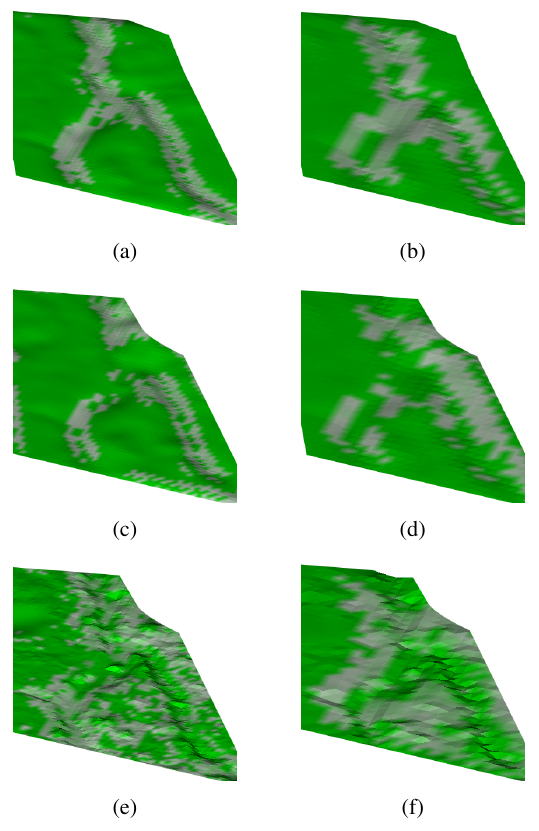
Figure 9. Detected key planes on the DEMs with different resoultions, key planes are drawn in gray. First row: DEMs for the ALS data a: cell size of 0.8 m b: cell size of 1.6 m; middle row: DEMs for the photogrammetric point cloud with a resolution of 40 cm with cell size of 0.8 m (c) and 1.6 m (d); last row: photogrammetric point cloud with a resoultion of 6 cm with cell size of 0.8 m (e) and 1.6 m (f)